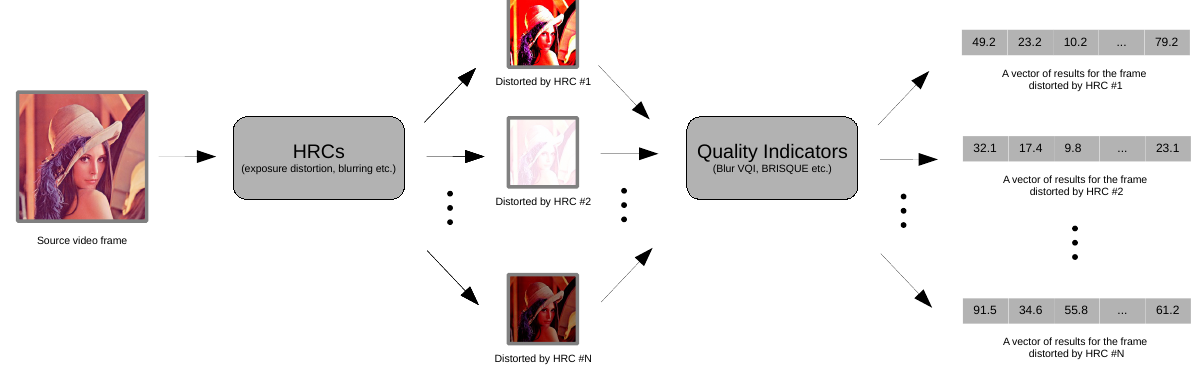
Figure 14. A flowchart presenting a processing pipeline in the quality experiment.